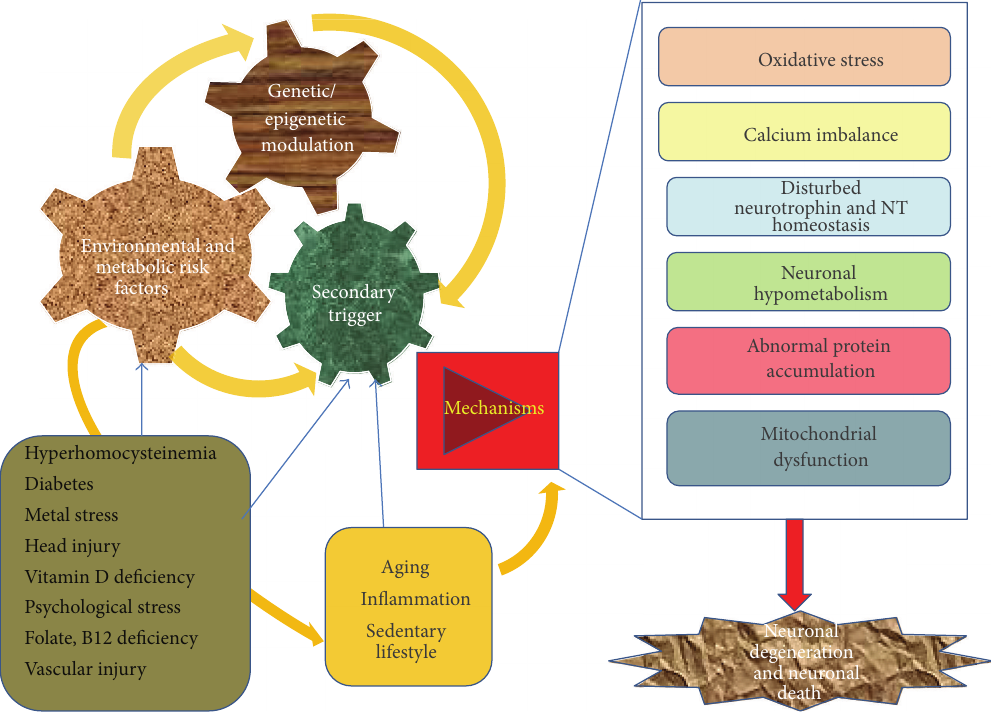
Figure 1: Risk factors and pathogenic mechanisms in the aetiopathogenesis of sporadic Alzheimer’s disease (AD).